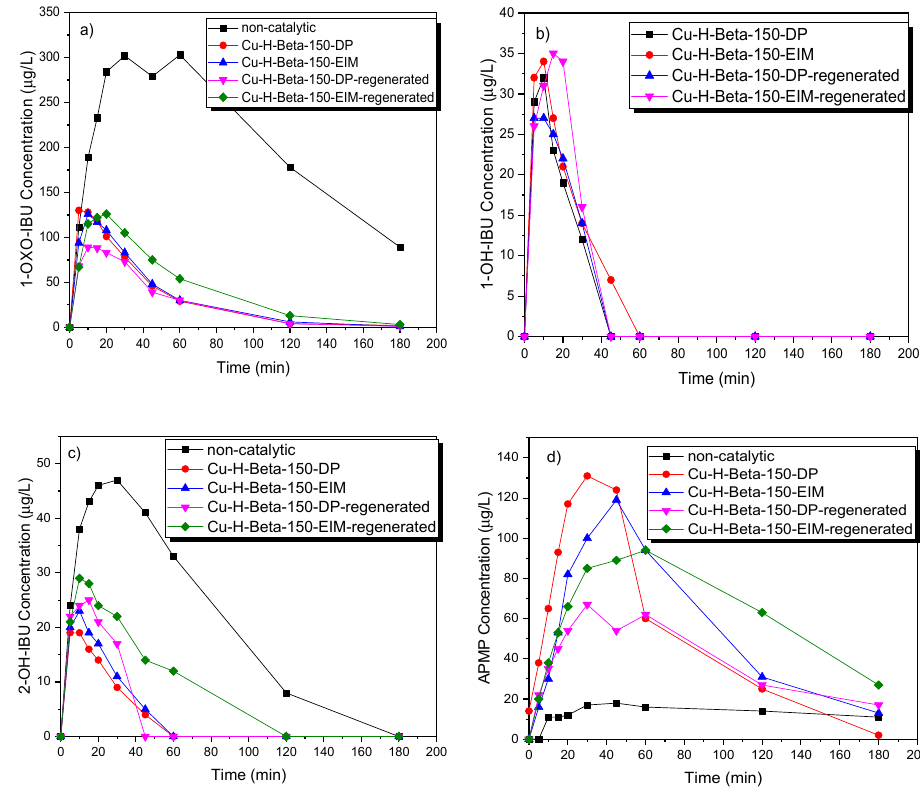
Figure 9. ( a ) 1-OXO-IBU, ( b ) 1-OH-IBU, ( c ) 2-OH-IBU, and ( d ) APMP concentration during the decomposition of IBU in the presence of 2.5 mL/min nitrogen. [IBU] = 10 mg/L, gas flow rate = 450 mL/min, T = 20 °C, stirring rate = 1070 rpm.